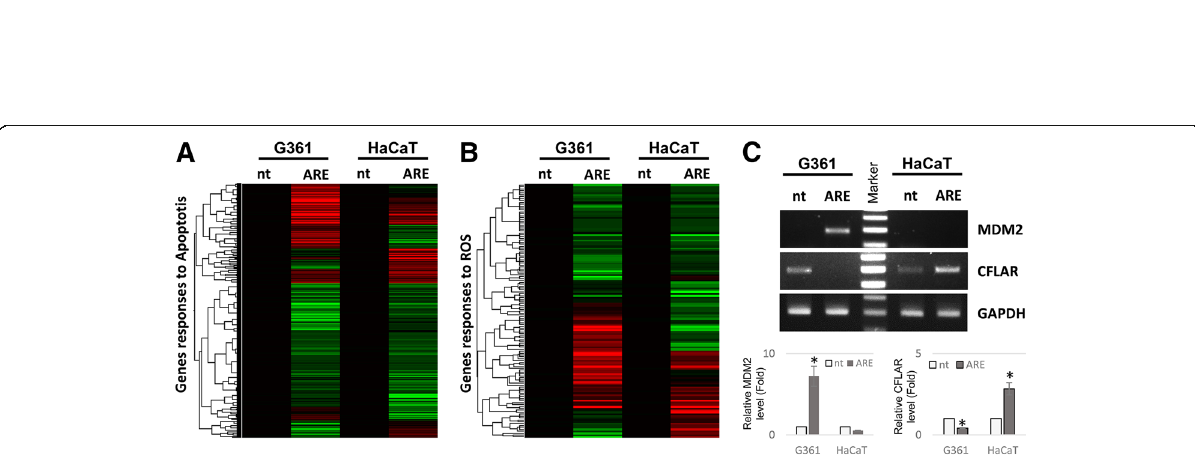
Fig. 6 cDNA microarray-based identification of MDM2 and CFLAR as genes responsible for ARE-mediated apoptosis in G361 cells. Genes showing more than 2-fold change after ARE treatment identified by cDNA microarray analysis using total RNA from G361 and HaCaT cells were classified into two groups; ( a ) apoptosis-related genes and ( b ) ROS-related genes. The change in gene expression levels in each group after ARE treatment is expressed as a heat map. The color intensity represents the extent of change; green indicates a decrease in gene expression, whereas red indicates an increase in gene expression. c The results of RT-PCR analysis of MDM2 and CFLAR genes are shown. GAPDH was used as a loading control. The relative expression of MDM2 and CFLAR mRNA were represented as graphs (bottom panel). Data represent the mean ± SEM ( n = 3). The significant changes after ARE treatment were marked as * ( p < 0.05) Table 1. The list of ROS and apoptosis related genes those differently regulated by ARE in G361 and HaCaT cells. The significant changes after ARE treatment were marked as * ( p < 0.05)